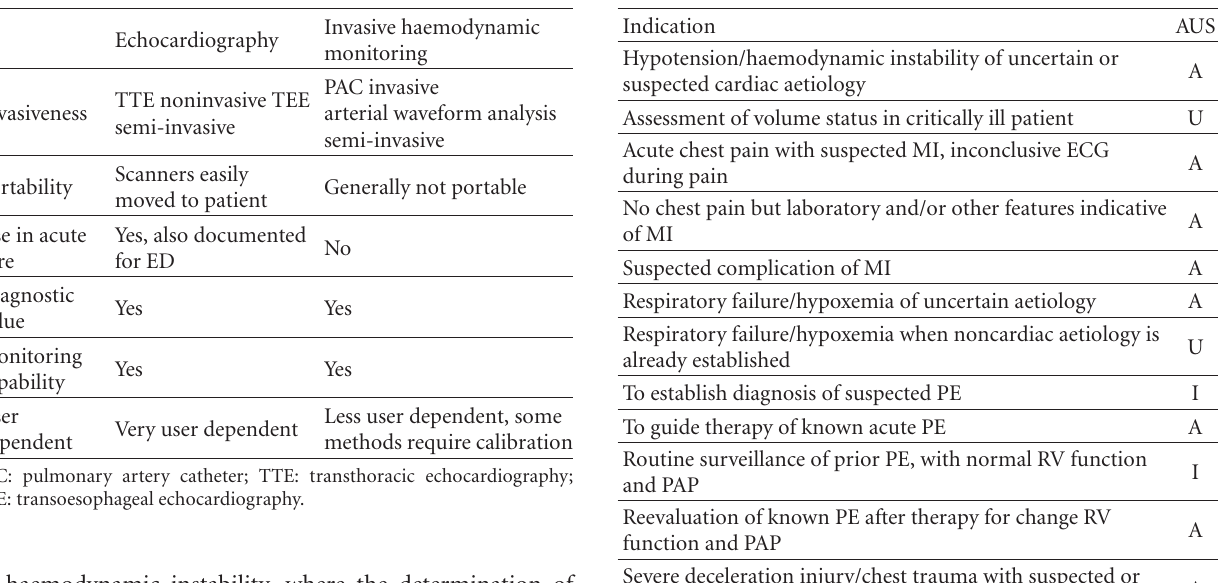
Table 1: Potential advantages and disadvantages of echocardiogra- phy versus invasive monitoring.